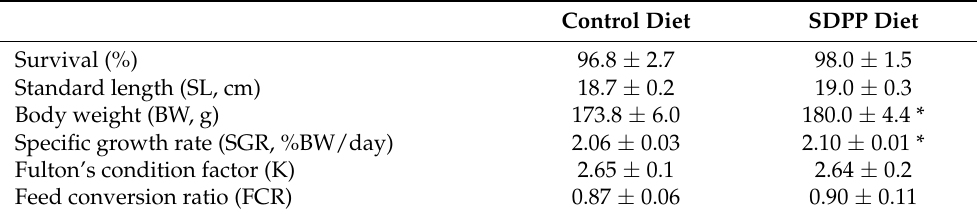
Table 2. Growth and feed key performance indicators of gilthead sea bream ( Sparus aurata ) juveniles fed low fishmeal diets containing 5% of spray-dried porcine plasma